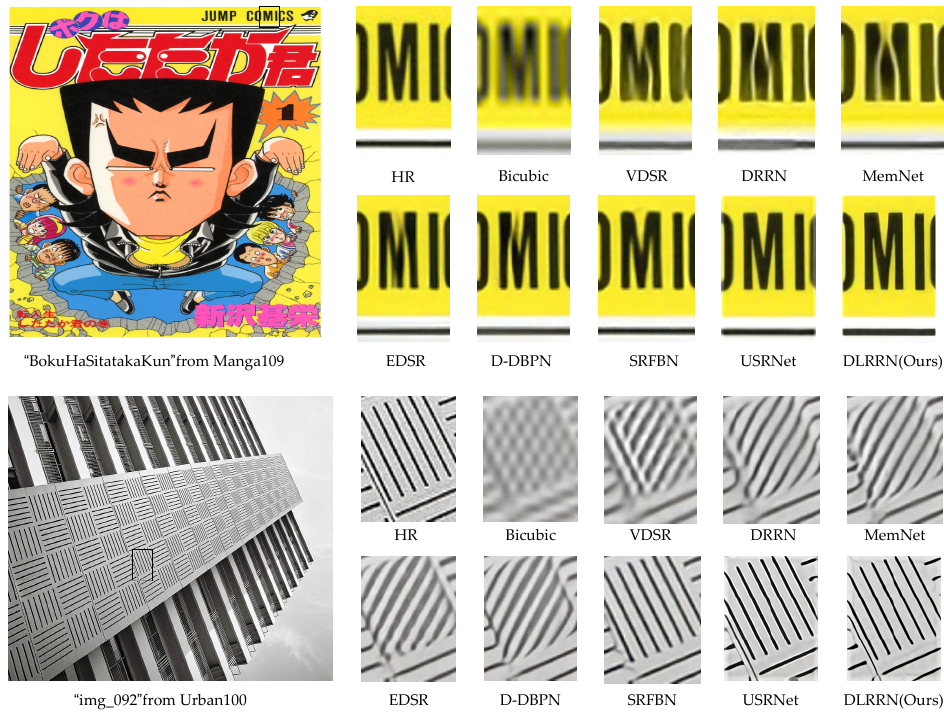
Figure 11. Comparison of the visual effect of the method in this paper with other methods on BI × 4.